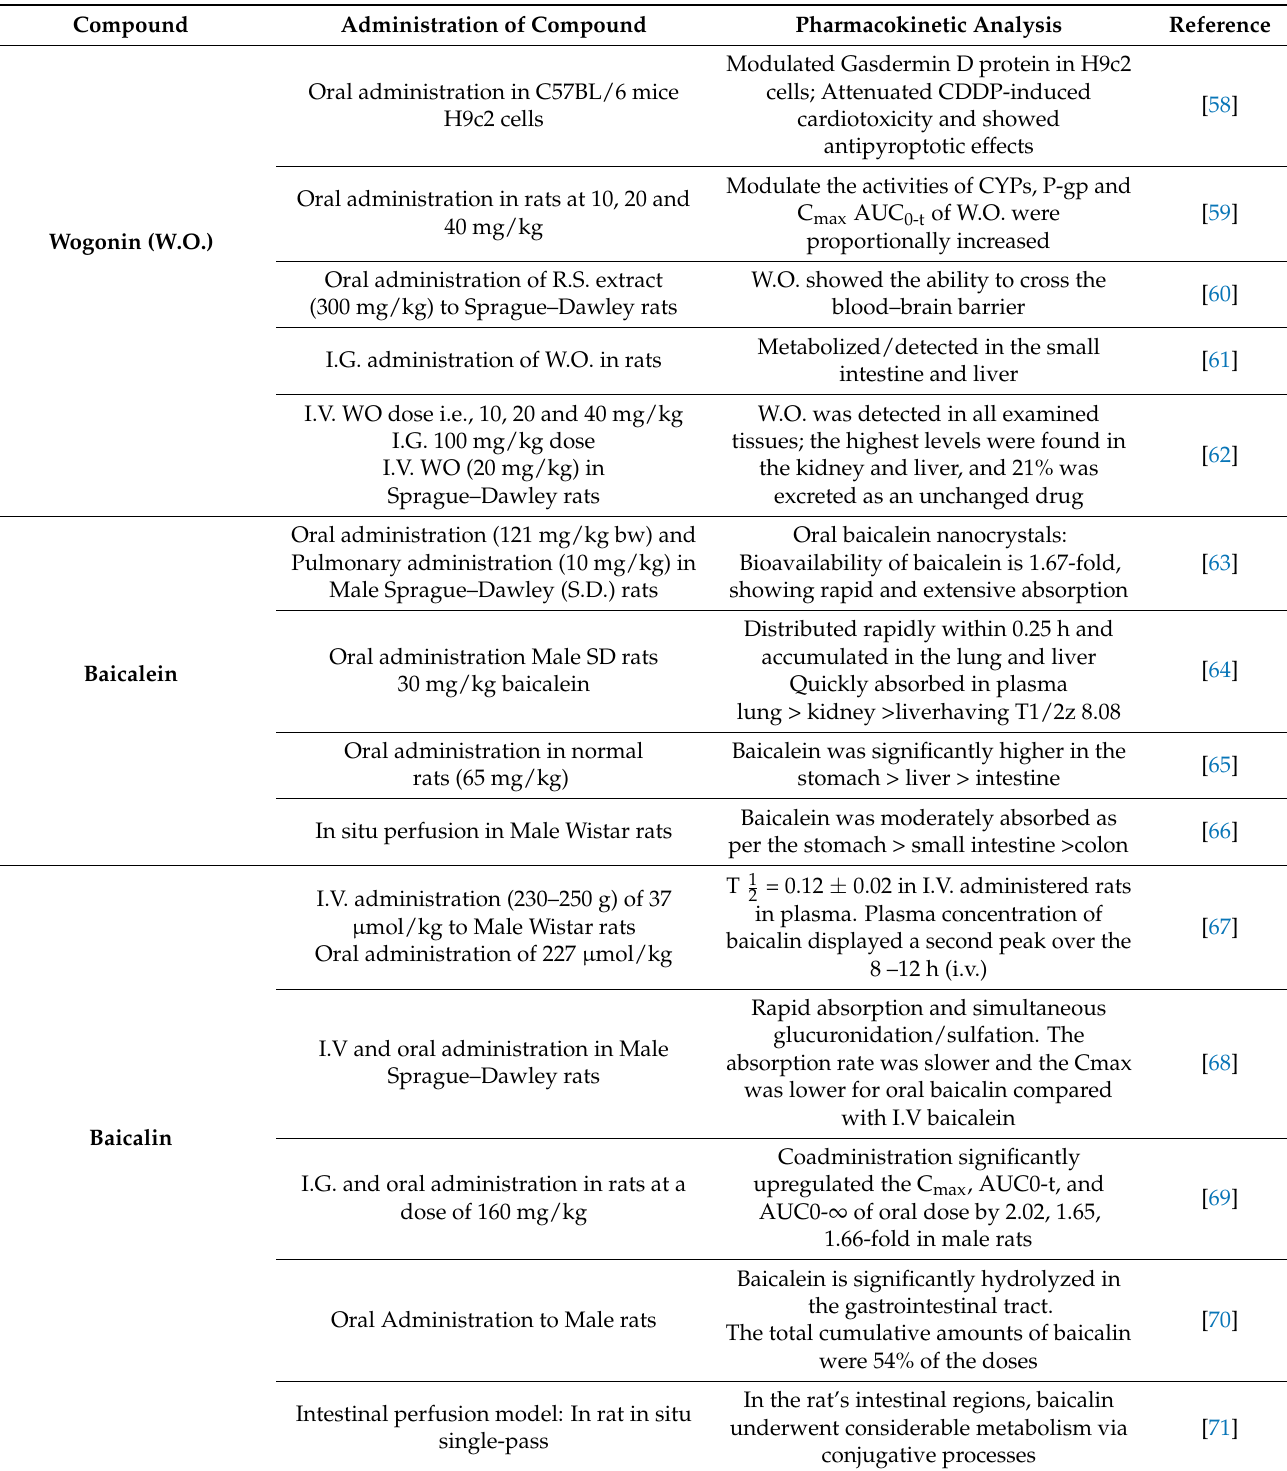
Table 2. Pharmacokinetic data of Scutellaria